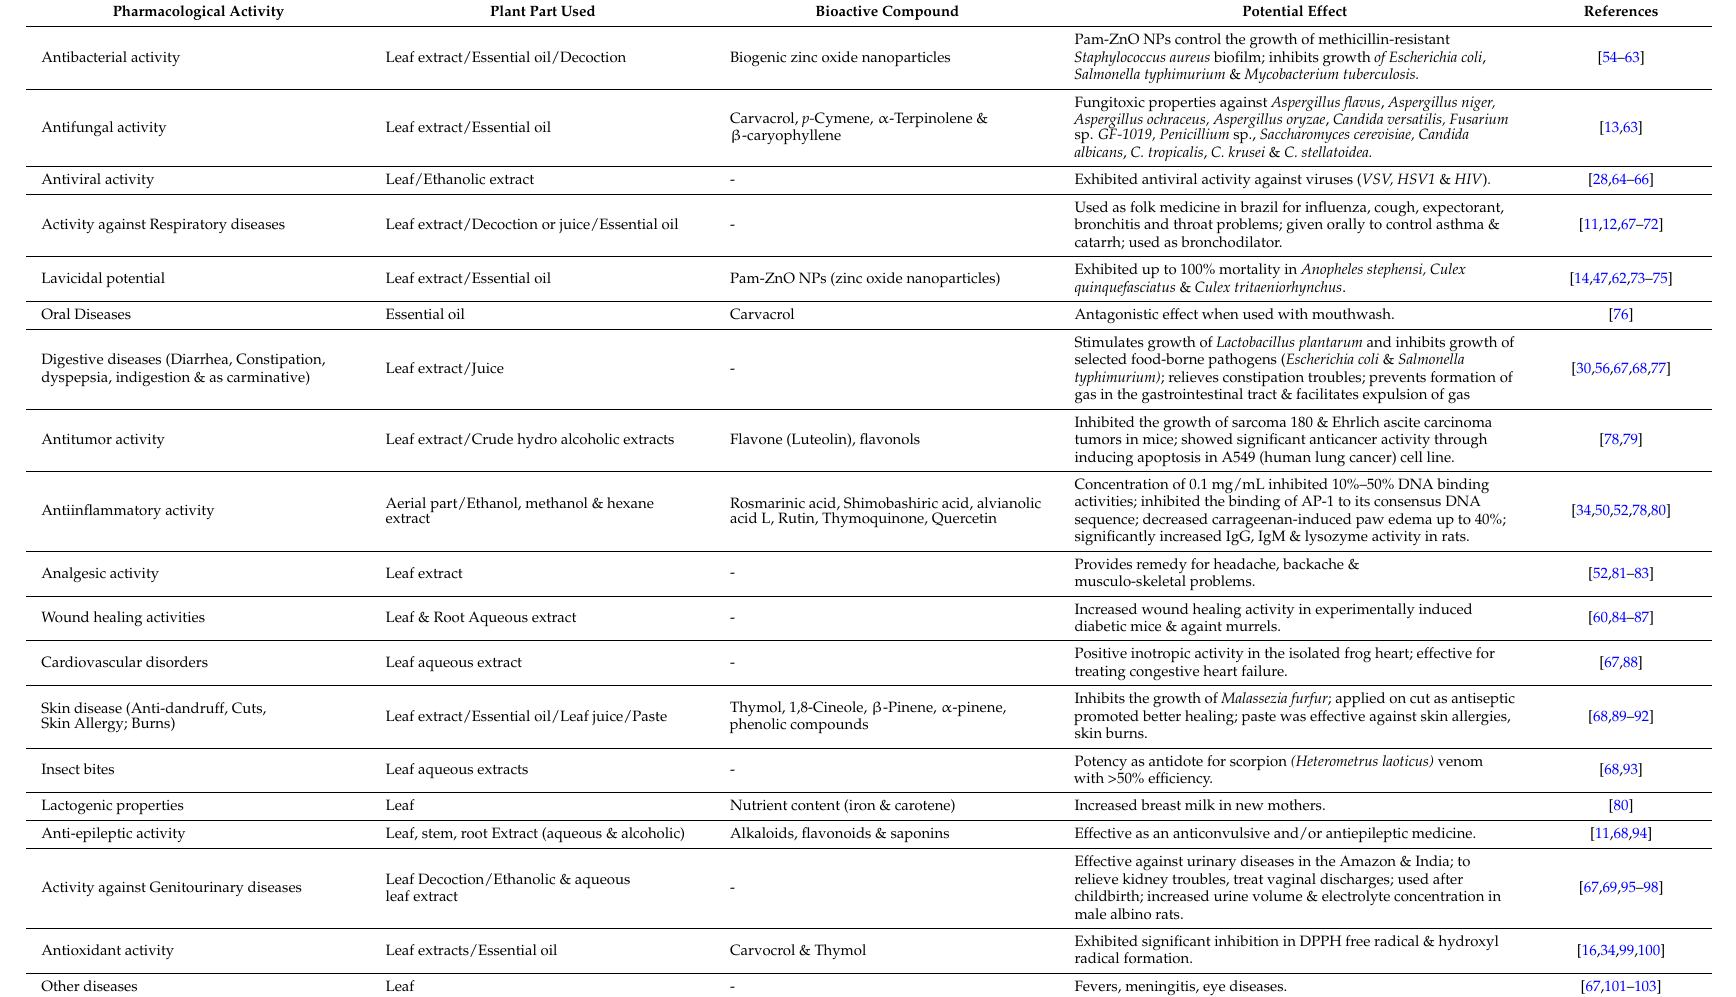
Table 4. Pharmacological properties of P. amboinicus different